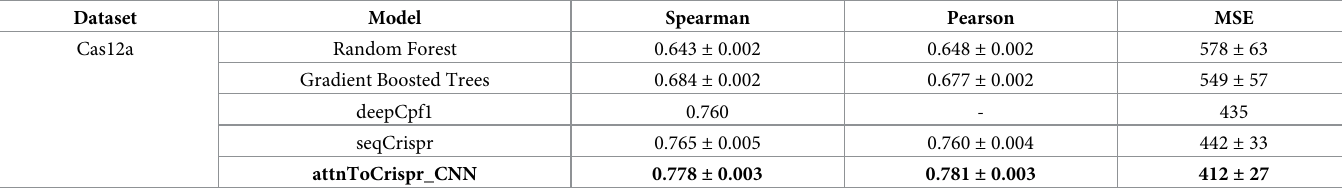
Table 2. Comparison of models performances on Crispr-Cas12a (Crispr-Cpf1) dataset. Spearman correlation, Pearson correlation, and mean squared error metrics (MSE) are compared.